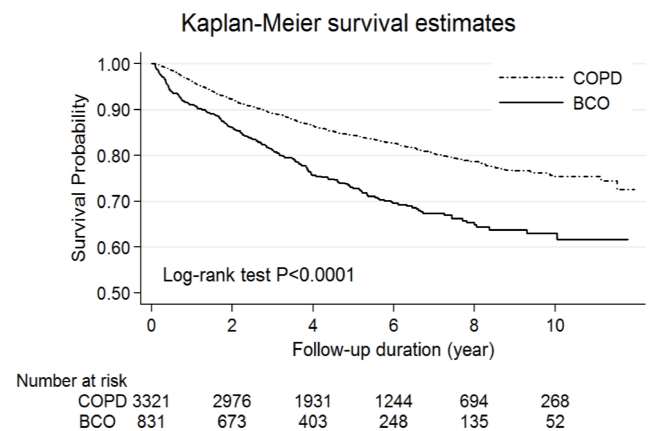
Figure 2. Kaplan-Meier curves for cumulative survival probability in the patients with chronic obstructive pulmonary disease (COPD) and bronchiectasis-COPD overlap (BCO). There was a statistically significant difference between the two curves (log-rank test, p < 0.0001).